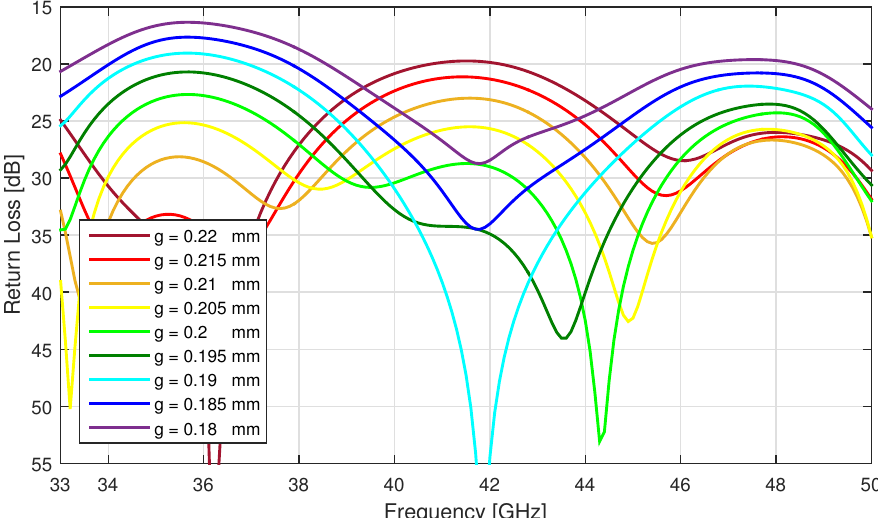
Figure 8. Tolerance analysis for the vertical offset of the pin insertion. The return loss is evaluated by varying the gap g between the pin and the upper WG